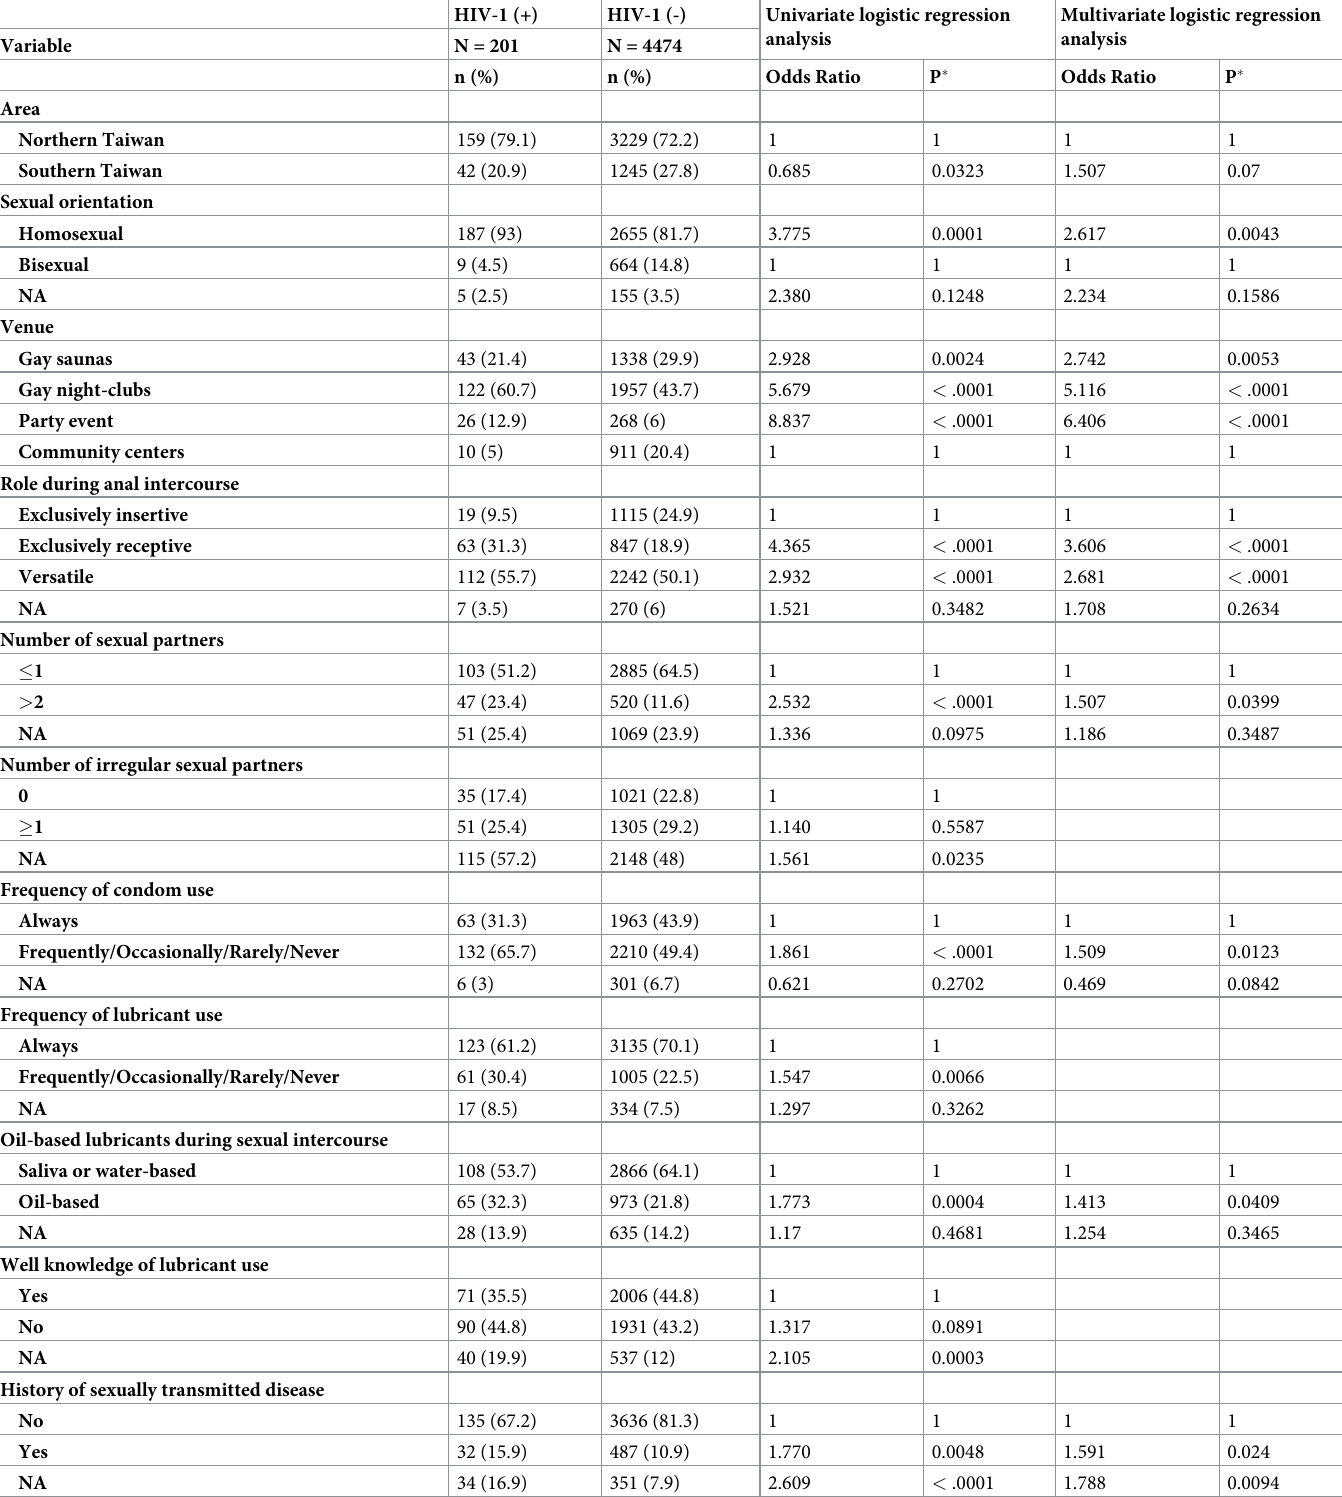
Table 3. Univariate and multivariate logistic regression analysis of risk factors for HIV-1 infection among MSM in